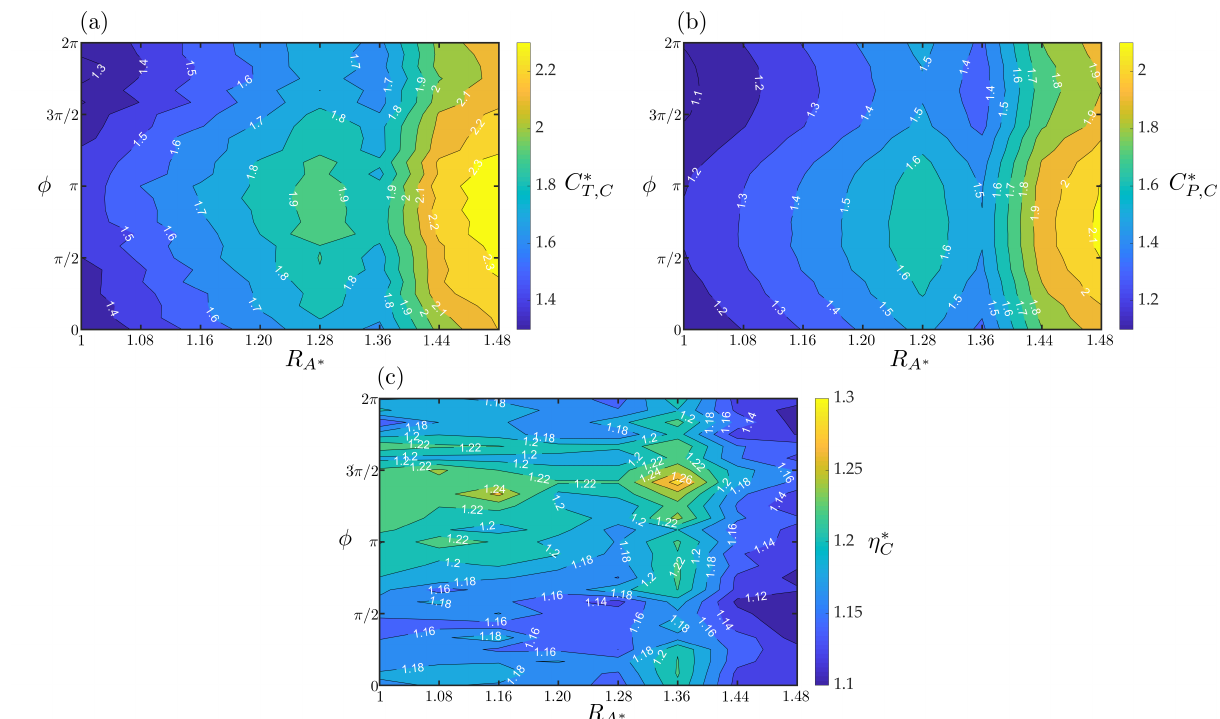
Figure 6. Normalized collective ( a ) thrust, ( b ) power and ( c ) efficiency as a function of synchrony and the follower-to-leader amplitude ratio for an in-line arrangement at ( X ∗ , Y ∗ ) = ( 0.5,0 )